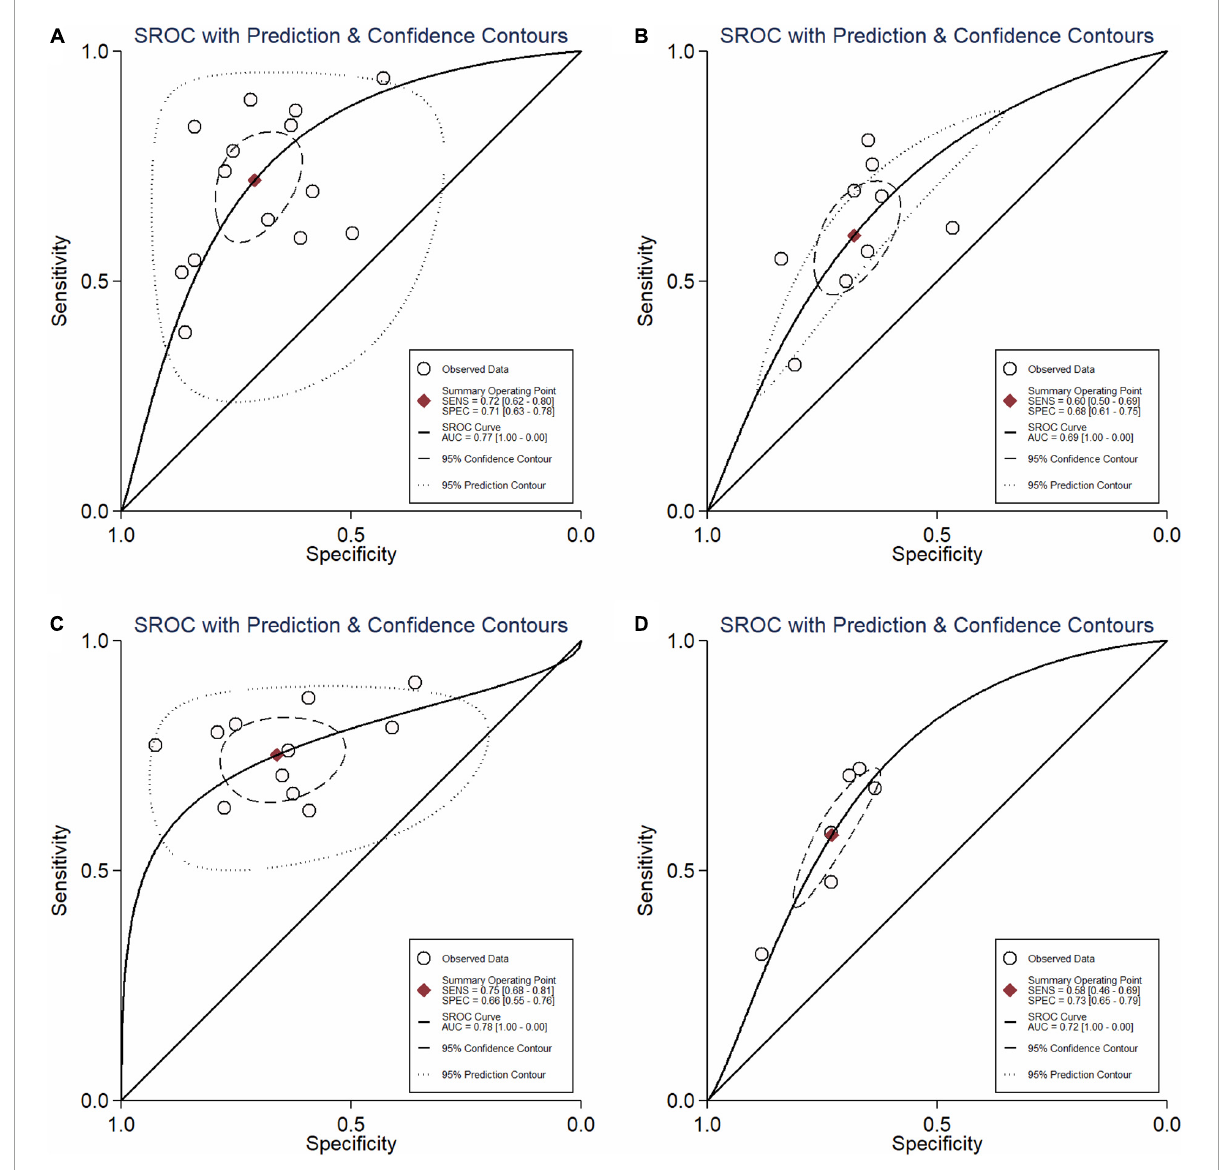
FIGURE4 Summary ROC curve (A) NLR; (B) PLR; (C) CRP; (D) NLR and PLR